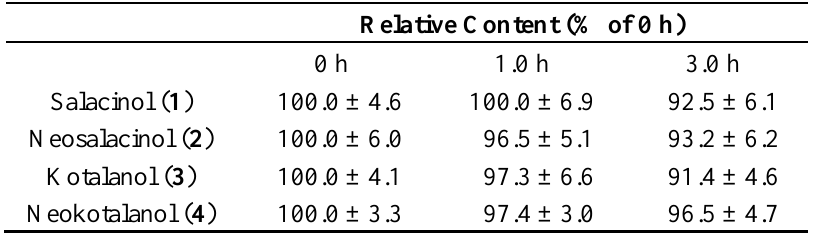
Table 7. Stability of sulfoniums ( 1 – 4 ) in artificial gastric